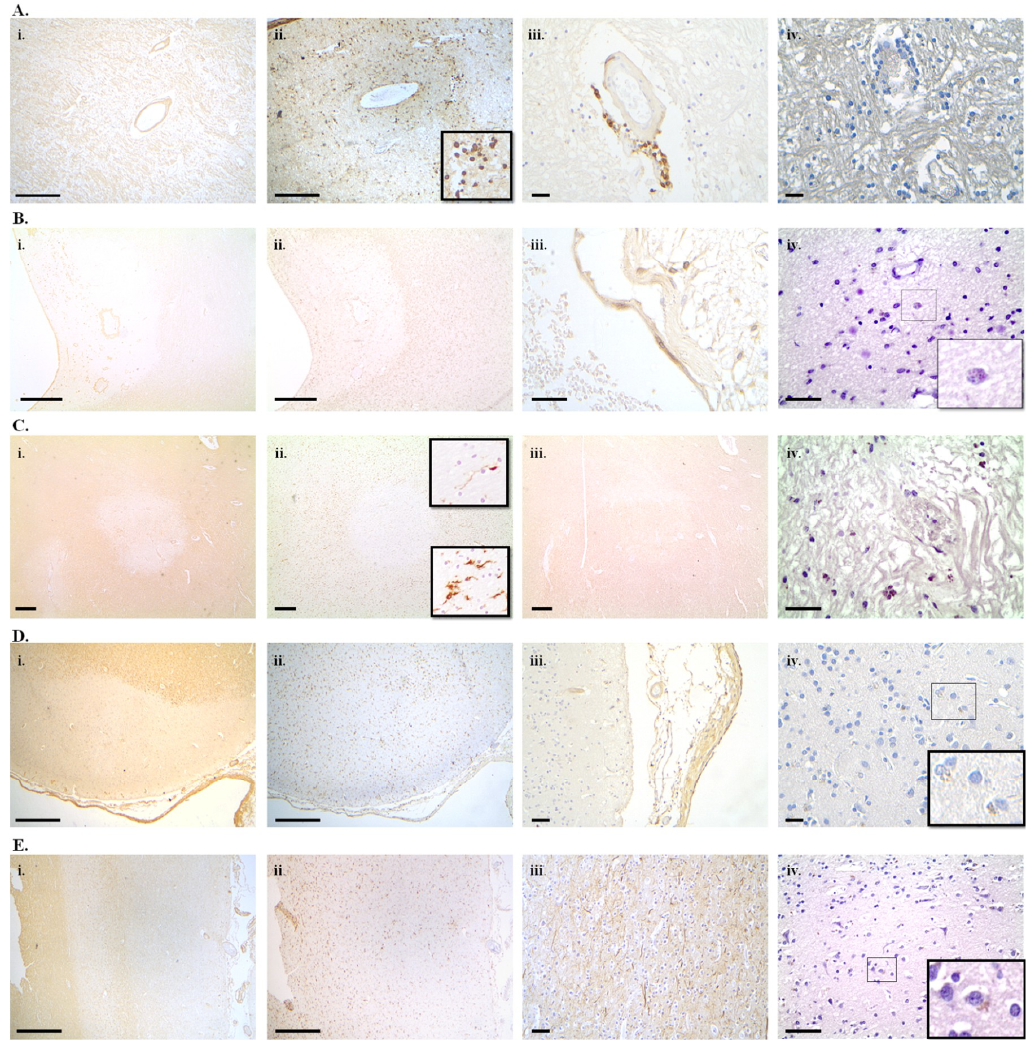
Figure 1. Lipofuscin accumulation as a marker of cellular senescence in multiple sclerosis lesions. Demyelinated lesions were identified with myelin basic protein (MBP) immunohistochemistry and were staged according to Trapp et al. (1998) [287] as acute active, chronic active or chronic inactive using human leukocyte antigen-DR isotype (HLA-DR) immunohistochemistry on serial sections from paraffin embedded postmortem tissue blocks. Lipofuscin was detected with the GL13 hybrid histochemistry-immunohistochemistry method [58]. Acute active demyelinated white matter lesion with MBP staining showing ongoing perivascular demyelination in subcortical white matter from the parietal lobe of a 73-year-old secondary progressive multiple sclerosis (SP-MS) patient (MS51) ( A ( i )) . Infiltration with HLA‐DR + cells with macrophage morphology throughout the demyelinated parenchyma (HLA DR immunohistochemistry) ( A ( ii )). Perivascular infiltration with CD8 + lymphocytes (CD8 immunohistochemistry) ( A ( iii )). GL13 staining in acute active lesions showed lipofuscin + cells. Although many of them were perivascularly localized, some were not, suggesting that at least some of them maybe glial cells rather than inflammatory cells ( A ( iv )). Chronic actively demyelinating perivenentricular white matter lesion with a fully demyelinated lesion center (lack of MBP immunoreactivity) from a 74‐year‐old female MS patient (MS265) ( B ( i )). Typically, HLA‐DR immunohistochemistry of serial sections exhibited a border infiltrated by numerous macrophages whereas the lesion centre is infiltrated by ramified microglia ( B ( ii )). Few CD8 + lymphocytes are present perivascularly (CD8 immunohistochemistry) ( B ( iii )). Lipofuscin + cells with granular staining were found in the macrophage infiltrated lesion border ( B ( iv )). Chronic inactive subcortical white